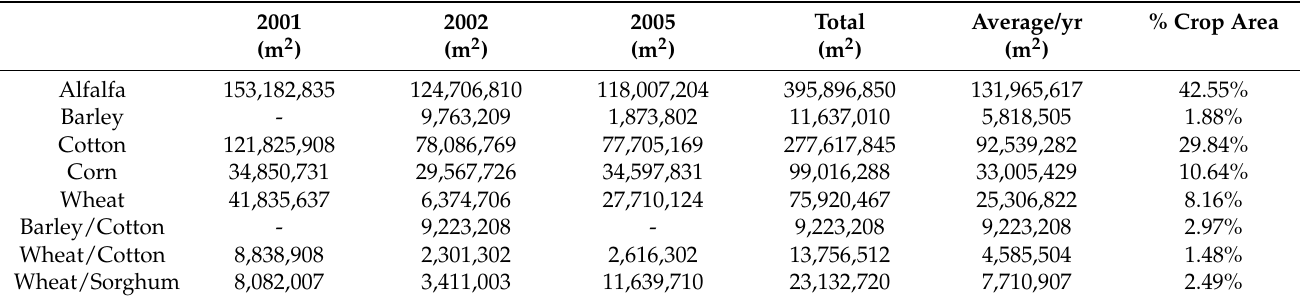
Table 9. Area by crop